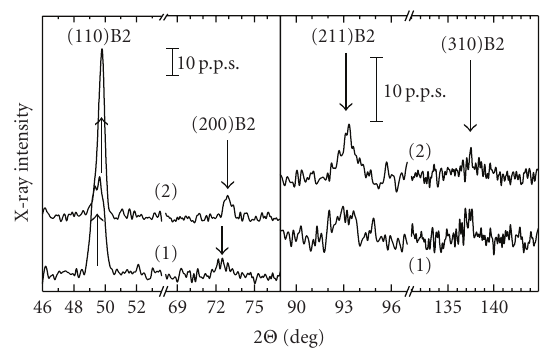
Figure 1: Fragments of X-ray di ff raction patterns for the TiNi specimens exposed to electron beam surface treatment with E 1 = 4J/cm 2 , Co-K α radiation, asymmetric di ff raction scheme: α = 0 . 15 ◦ (1) and α = 2 ◦